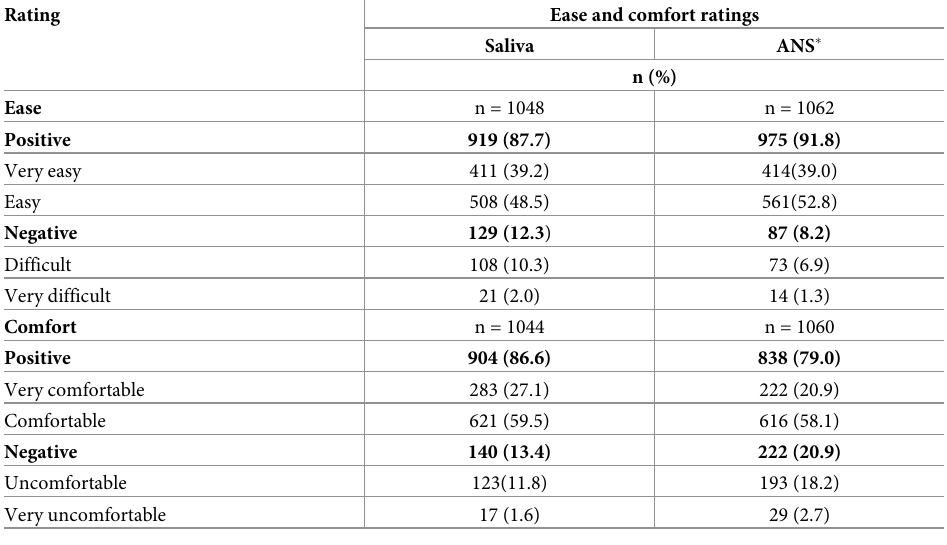
Uncomfortable 123(11.8)